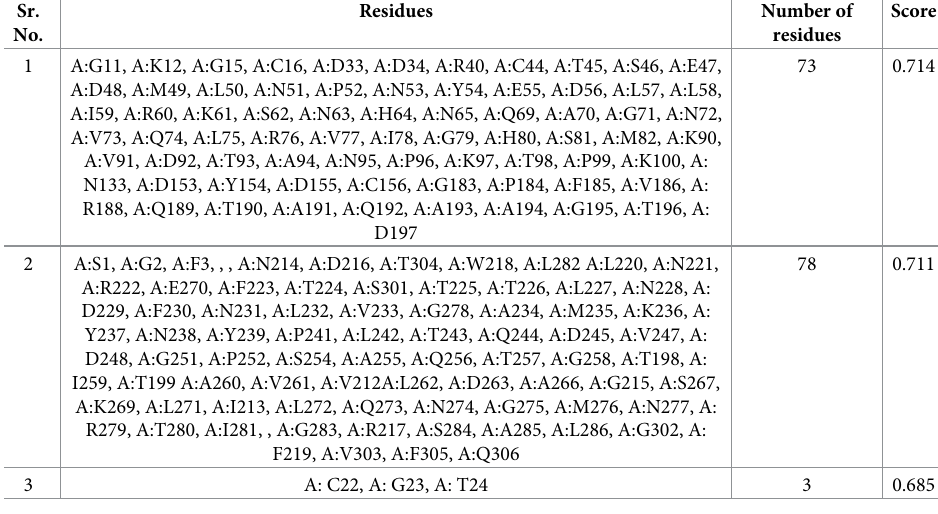
Table 2. Top-ranked selected discontinuous epitopes, interacting residues, and scores predicted discontinuous epitopes. Sr. No.